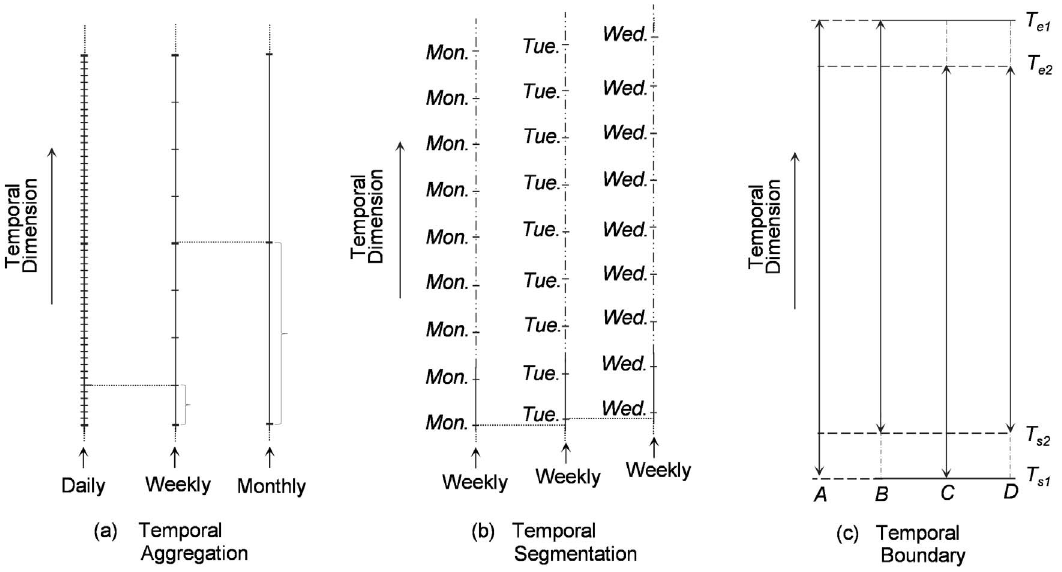
Figure 1. Modifiable Temporal Unit Problem (MTUP) (a) Temporal aggregation (b) Temporal Segmentation (c) Temporal boundary.